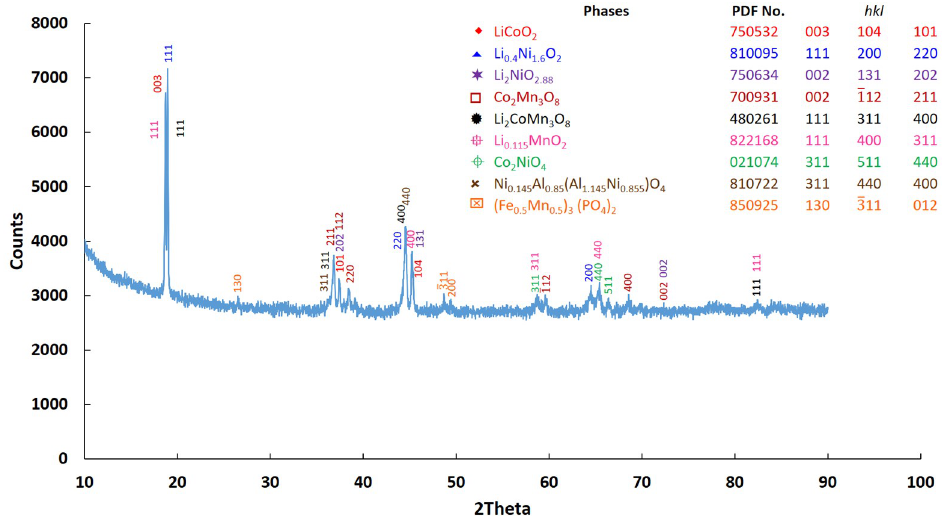
Figure 1. XRD pattern of the cathode powder of spent LIBs along with the identified phases (PDF number in parenthesis).